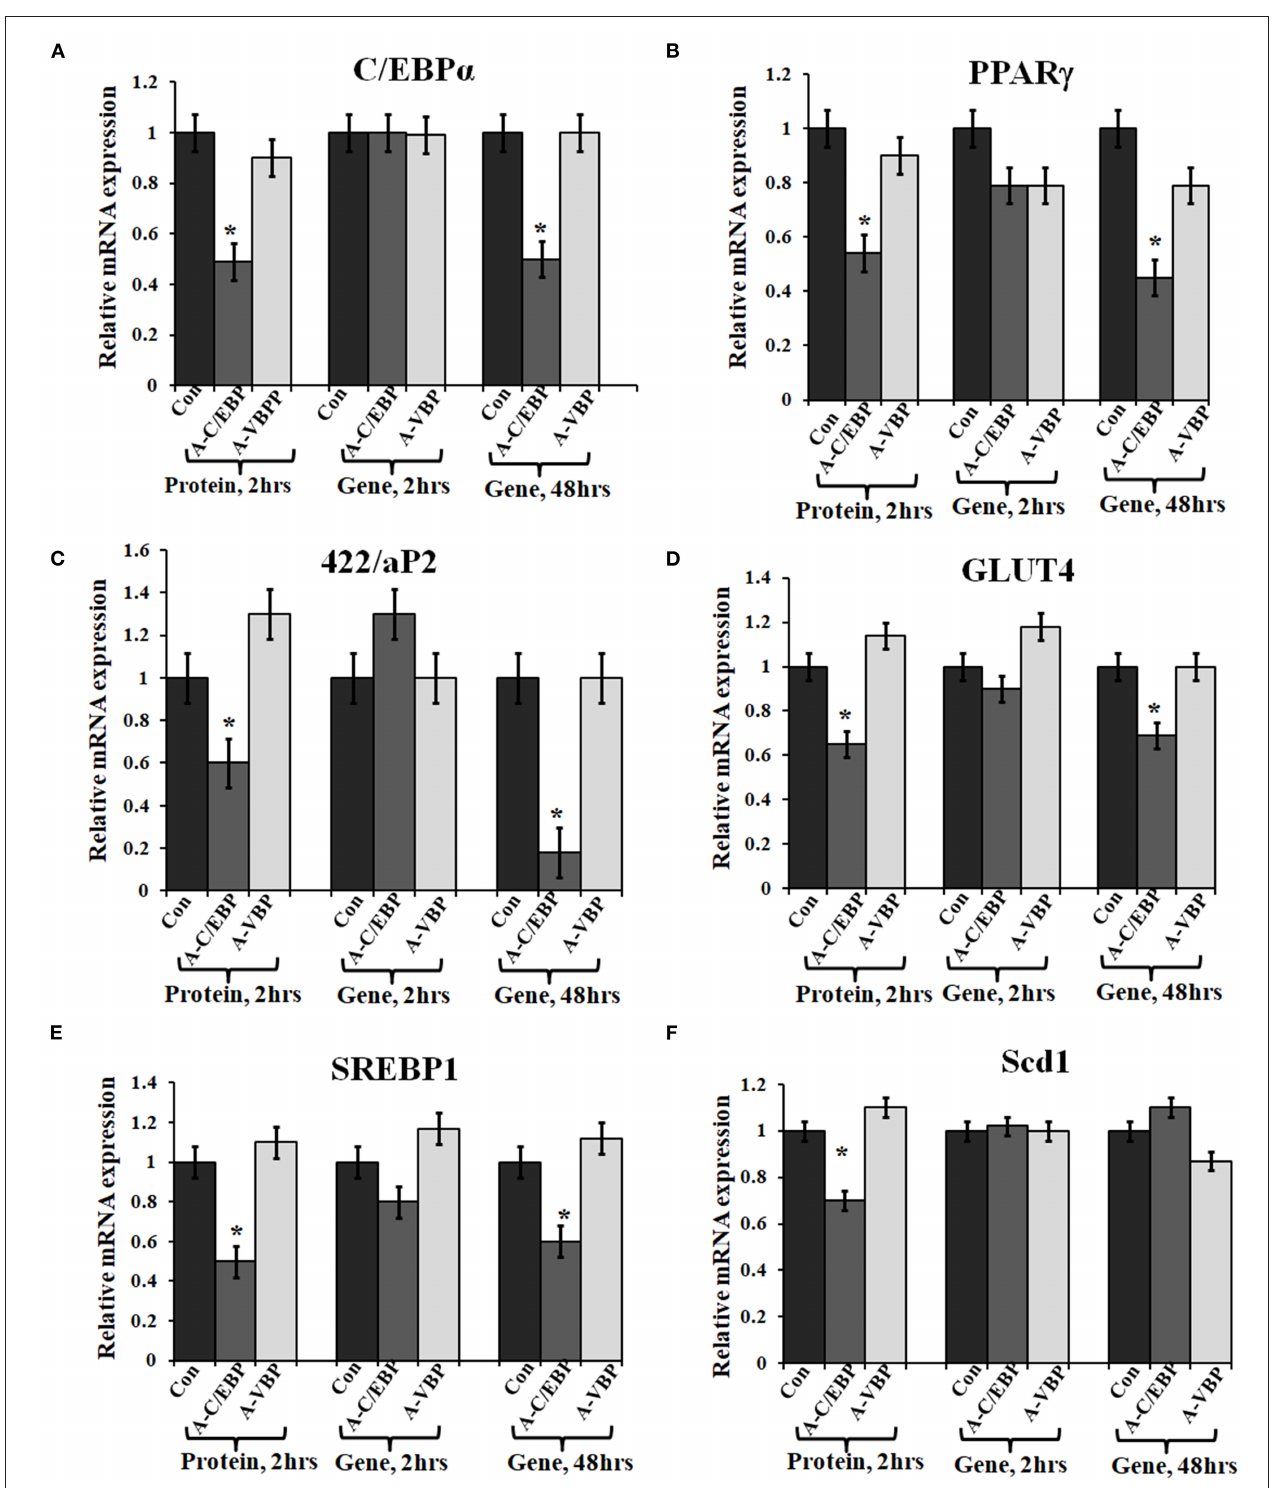
FIGURE 3 | Effect of A-C/EBP and A-VBP protein and gene on six adipocyte marker genes. (A–F). Gene expression analysis for comparative expression of C/EBP α , PPAR γ , 422/aP2 , GLUT4 , SREBP1 , and Scd1 w.r.t. actin expression. 3T3-L1 cells were transfected with A-C/EBP and A-VBP protein. A-VBP is a designed dominant-negative of VBP transcription factor and used as a negative control here. All six marker genes show downregulation in cell samples transfected with 3 µ M A-C/EBP protein, whereas only 48h gene samples showed significant decrease. Since neither A-VBP protein nor its gene has any effect on the expression of six adipocyte marker genes, we conclude that A-C/EBP is specific in inhibiting preadipocyte 3T3-L1 cells differentiation. *Indicate significantly different from control ( p < 0.05). Values are expressed as mean ± SD; n = 6 independent experiments.